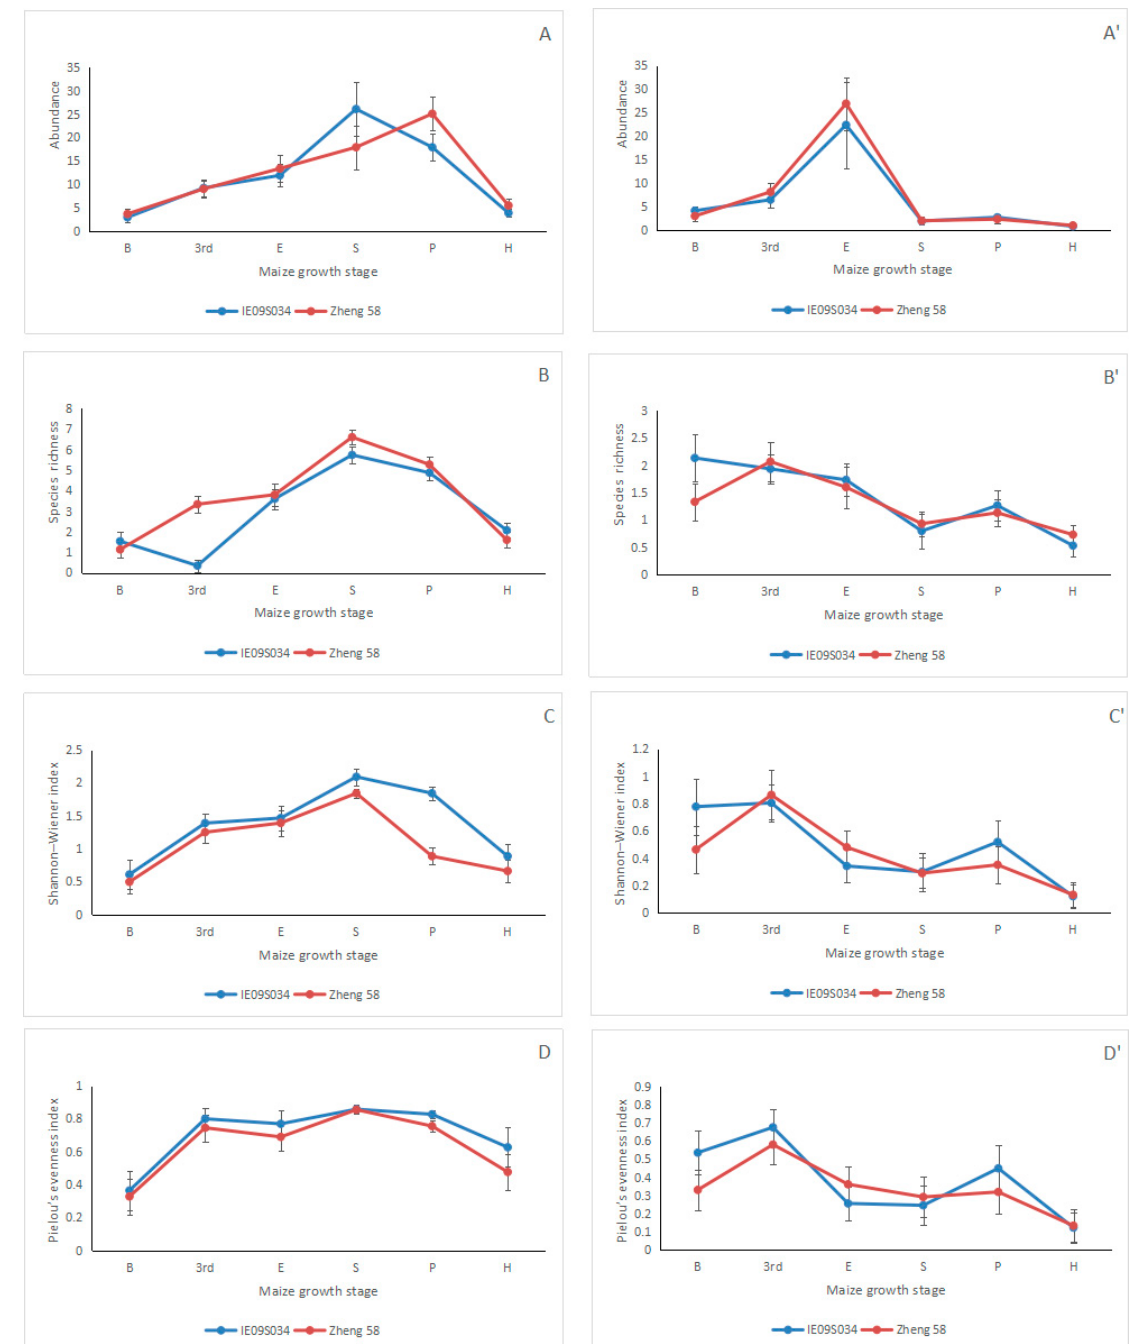
Figure 1. Collembolan abundances and diversity parameters (mean ± SE) in different maize variety fields (transgenic Bt maize IE09S034 and its near isoline of non-Bt maize Zheng 58) in Northeast China in 2014 and 2015. Maize growth stage “B”, “3 rd ”, “E”, “S”, “P”, and “H” are shorted for “before sowing”, “3rd leaf”, “elongation”, “silking”, “physiological maturity”, and “harvesting”, respectively. ( A ) is the collembolan abundance in 2014; ( A' ) is the collembolan abundance in 2015; ( B ) is the collembolan species richness in 2014; ( B' ) is the collembolan species richness in 2015; ( C ) is the collembolan Shannon-Wiener index in 2014; ( C' ) is the collembolan Shannon-Wiener index in 2015; ( D ) is the collembolan Pielou's eveness index in 2014; ( D' ) is the collembolan Pielou's eveness index in 2015.